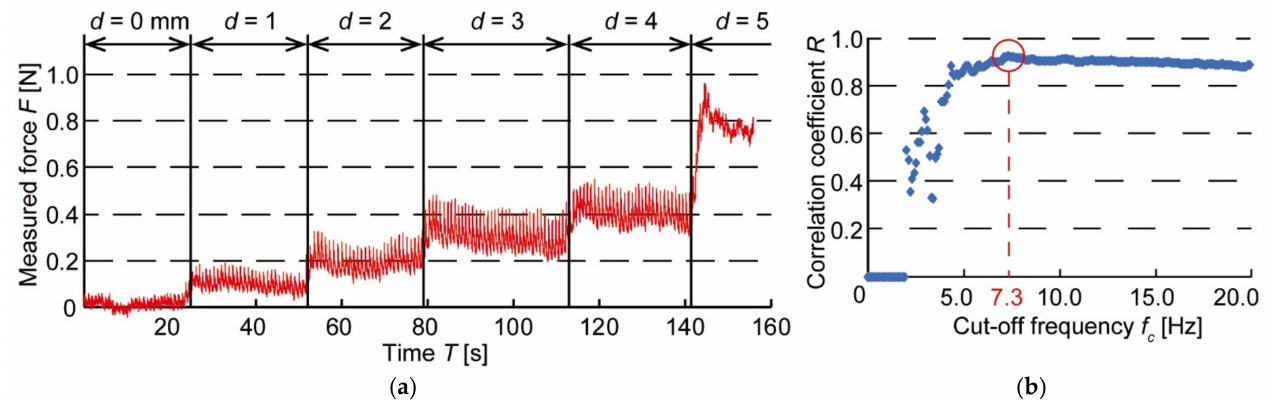
Figure 7. Results of pushing force change experiment: ( a ) Waveform of blood pressure pulse wave when pushing force is varied; ( b ) Changes in correlation coefficient between the amplitude of blood pressure A P and discriminant index LF / HF when cut-off frequency f c is varied.